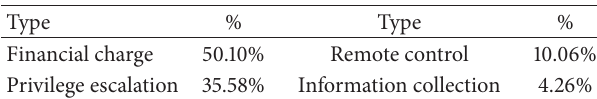
Table 6: Distribution of malware Apps in the nonofficial market according to their